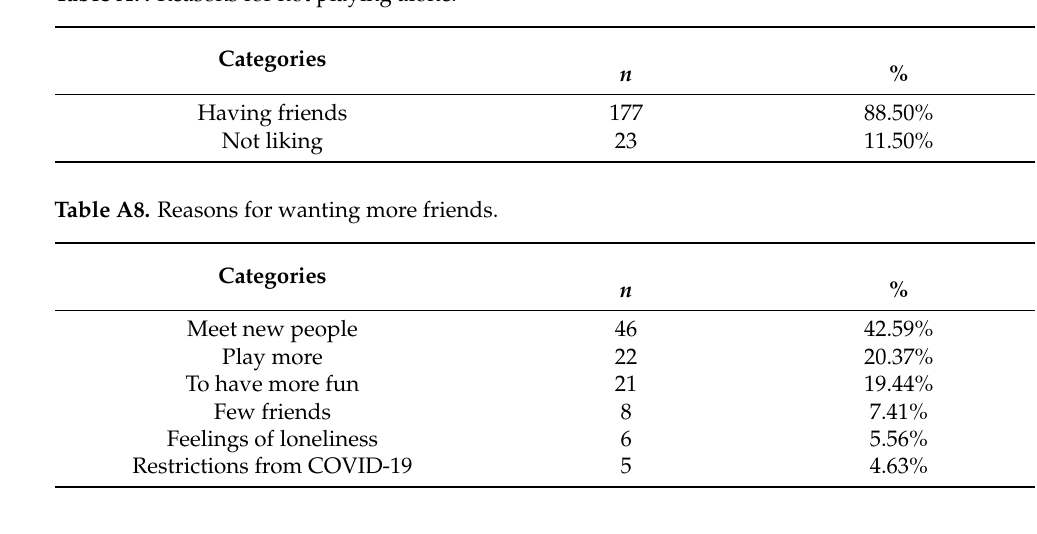
Table A7. Reasons for not playing alone.